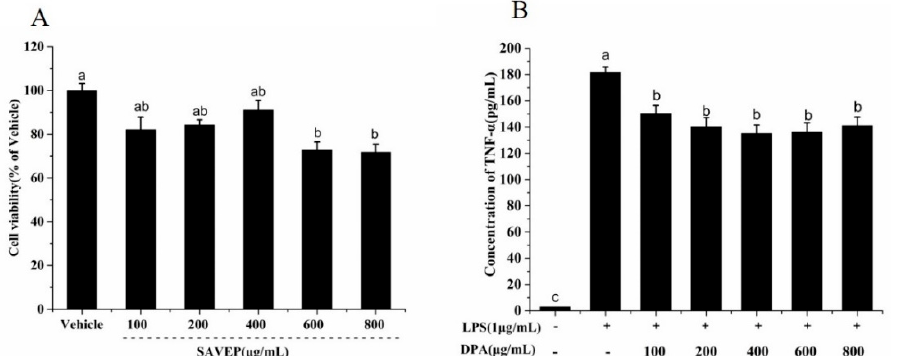
Figure 2. Screening of anti-inflammatory activity of the SAVEP. ( A ) Effects of different concentrations of SAVEP on cell viability. ( B ) Screening of anti-inflammatory activity concentration of SAVEP. Statistical analysis was performed using a one-way ANOVA with Tukey’s test. Data represent the mean ± SD ( n = 6). Different letters represent significant differences between groups ( p < 0.05).